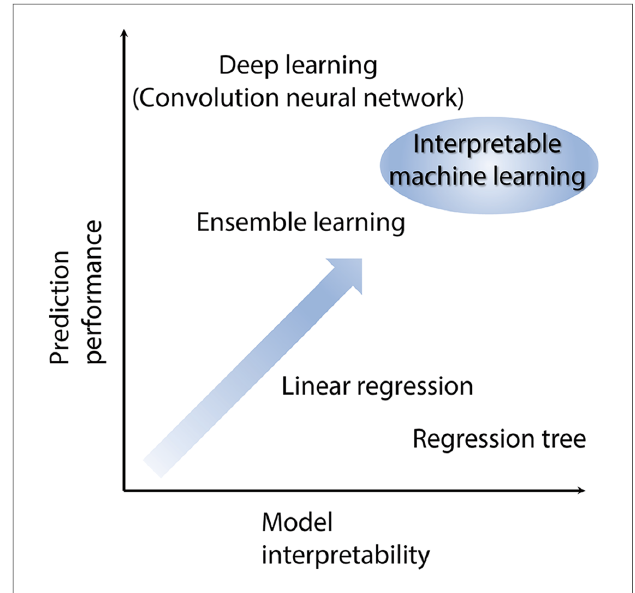
FIGURE 2 Relationship between prediction performance and model